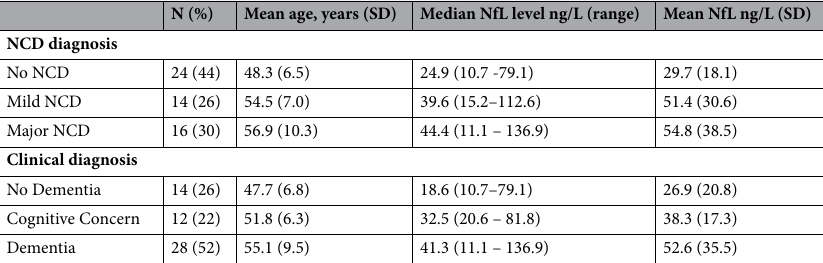
Table 4. Average NfL levels for individuals grouped according to DSM-5 criteria and for groups according to clinical